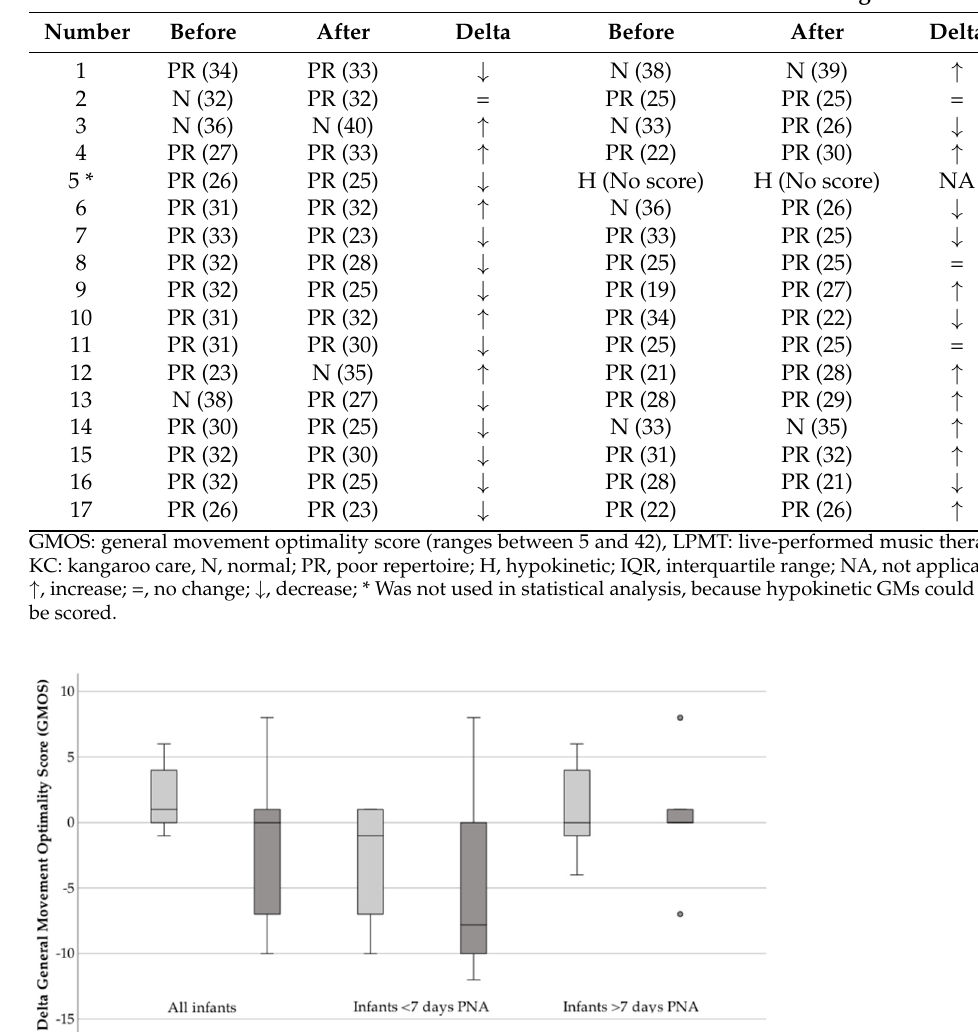
Table 2. The GMOS and quality of general movements per individual infant before and after LPMT alone and combined interventions. Infant GMOS LPMT GMOS LPMT during KC Number Before After Delta Before After Delta 1 PR (34) PR (33) ↓ N (39) ↑ N (32) PR (32) = PR (25) PR (25) = 3 N (36)